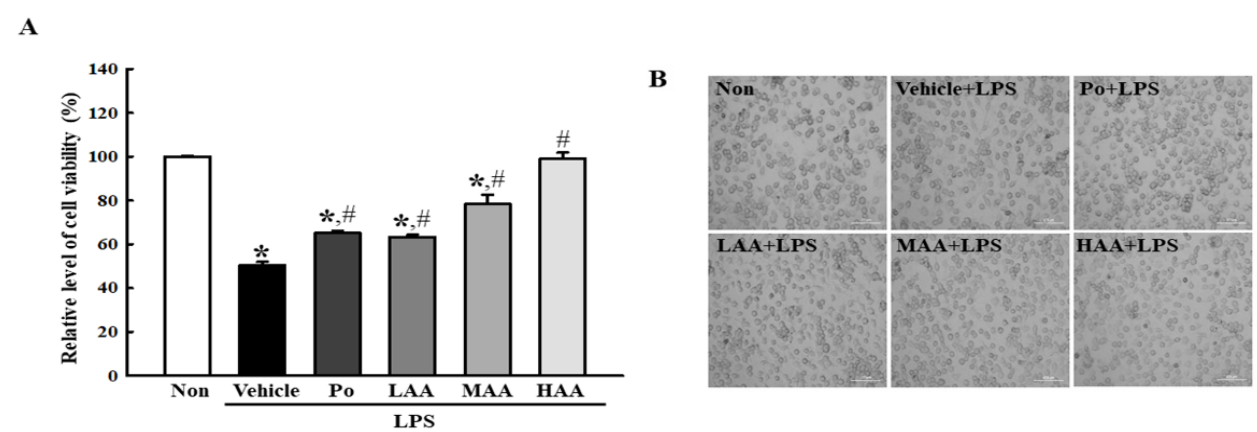
Figure 3. Viability of RAW264.7 cells treated with AA. ( A ) Cell viability. MTT assay was performed on three wells per group and the optical density was analyzed in duplicates. All values in the results are represented as the means ± standard deviation (SD). * indicates statically significance compared to the non-treated group, while # indicates statically significance compared to the Vehicle+LPS- treated group. ( B ) Microscopic image of AA+LPS-treated cells. These cells were observed using a light microscope at 200× magnification. Abbreviations: AA, abietic acid; LPS, lipopolysaccharide; Po, positive control; LAA, low concentration of AA; MAA, medium concentration of AA; HAA, high concentration of AA.